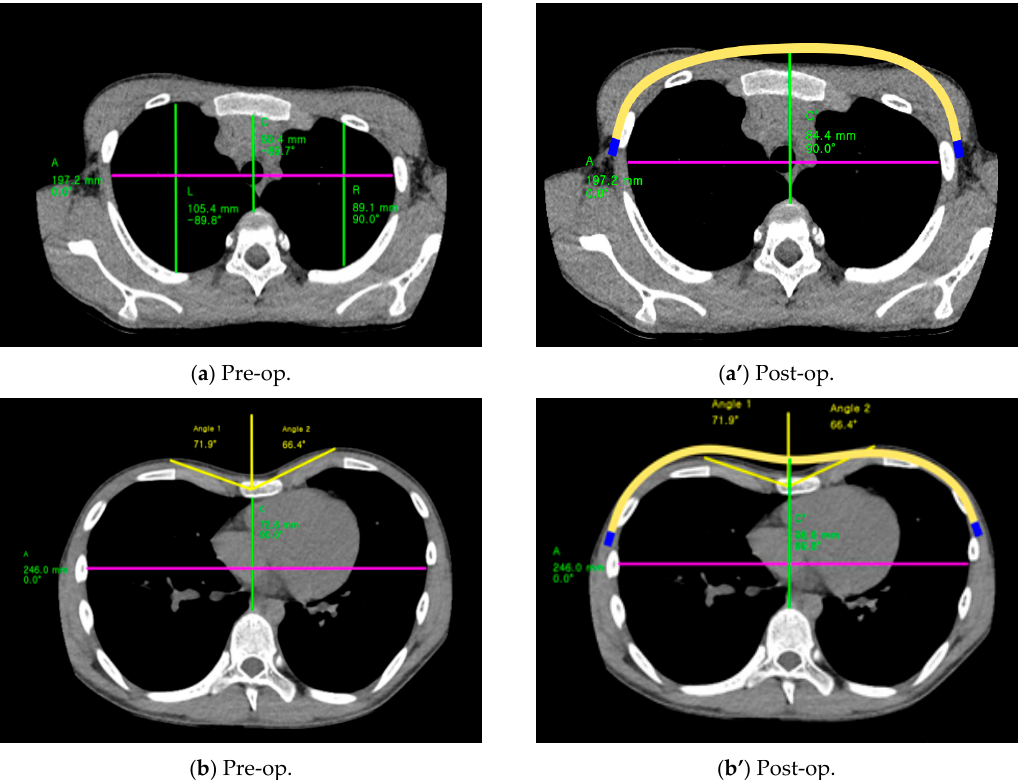
Figure 12. CT images of asymmetric patients. ( a ) and ( b ) are CT images taken before the Nuss operation; ( a’ ) and ( b’ ) are images taken after the Nuss operation. Yellow lines in ( a’ ) and ( b’ ) show the patient-specific Nuss bar.